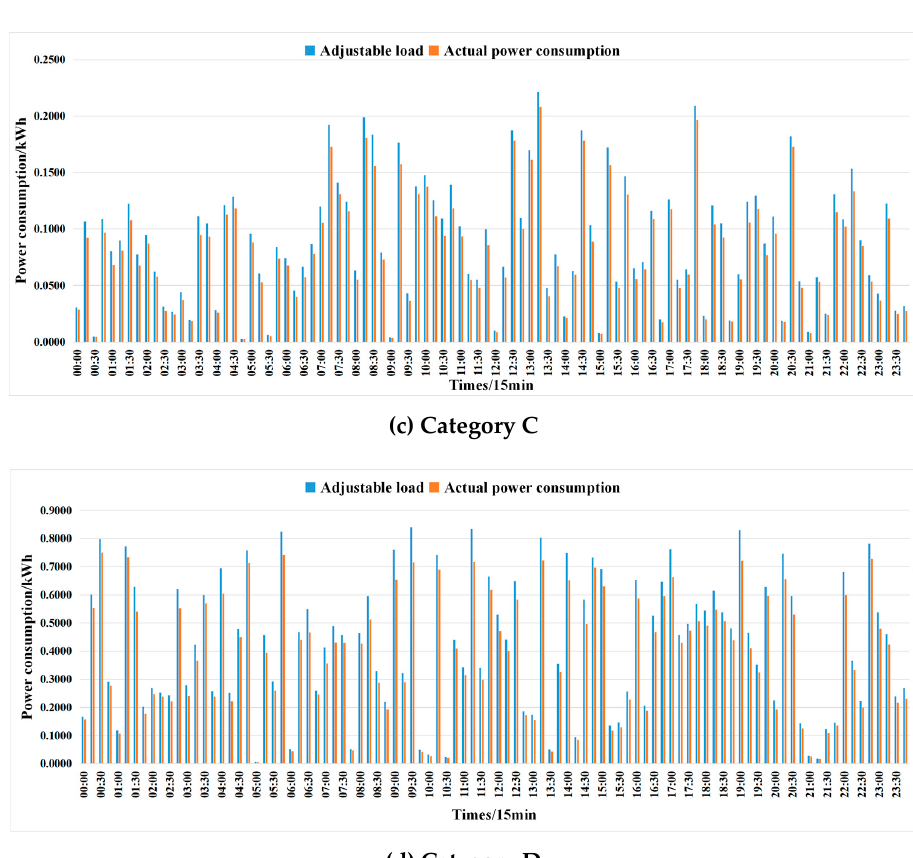
Figure 8. The execution effect of DDPG model on four types of customers.